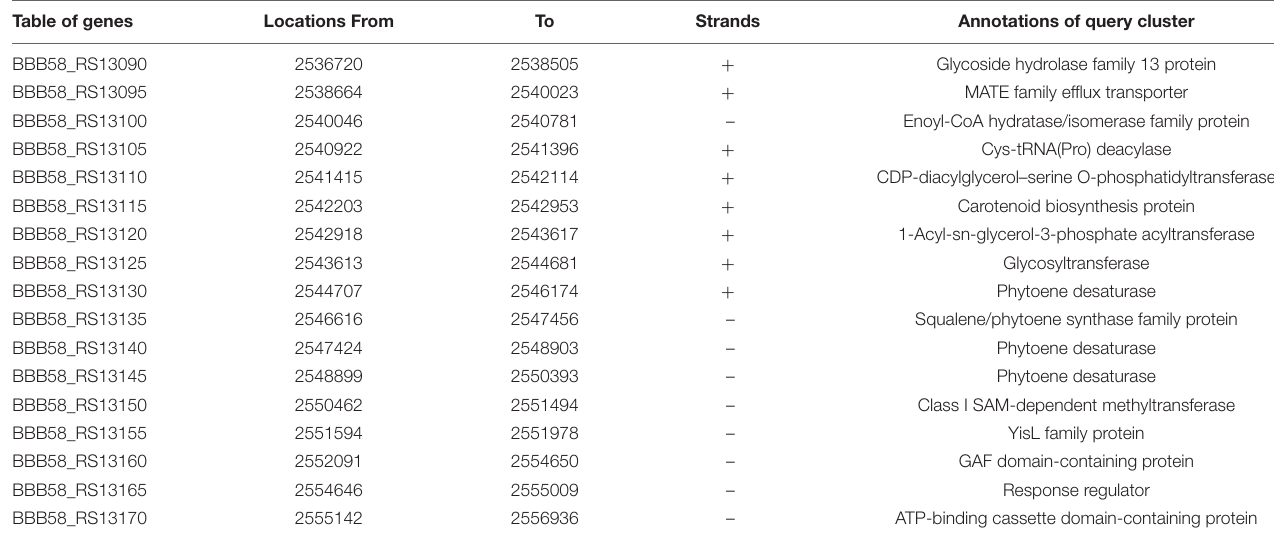
TABLE 3 | List of identified genes in 17th BGCs (Region 1.17) of the terpene synthesis pathway. Table of genes Locations From To